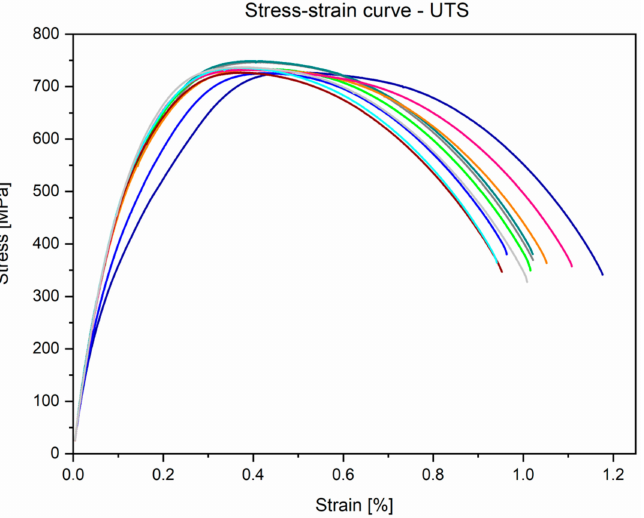
Figure 8. Experimental stress–strain curves obtained from the static tensile test for Ti-13Nb-13Zr alloy. Results of three-point bending and curves obtained in this test are found on the flexural strength versus deflection curve (Figure 10). The figure below shows the area of elastic deformation up to 1200 MPa, plastic deformation 1600–1800 MPa, and cracks marked by a clear decrease in